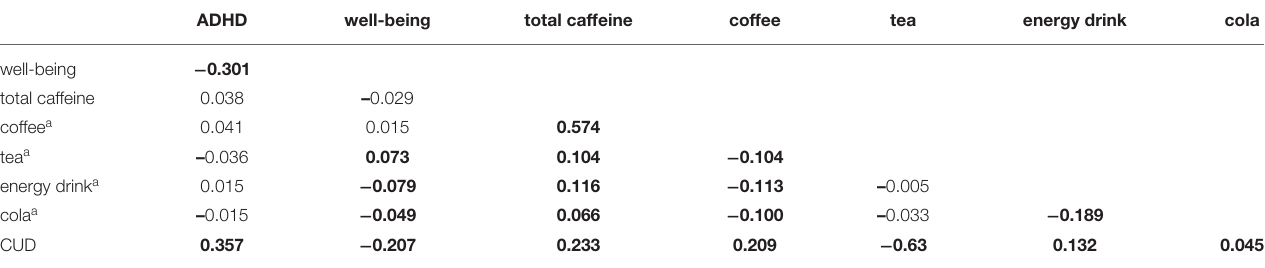
TABLE 1 | Correlation matrix of the variables in the present study. ADHD well-being total caffeine coffee tea energy drink cola